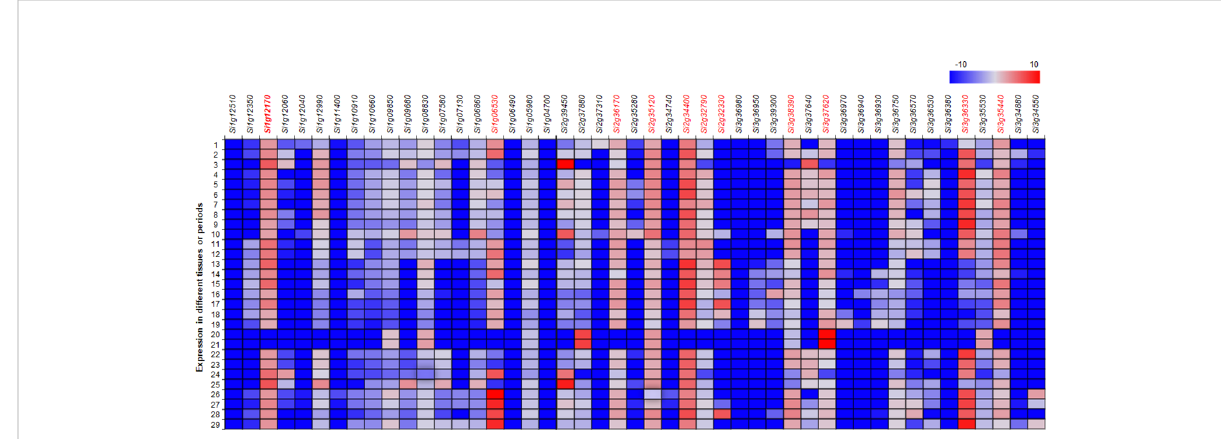
FIGURE 4 Heatmap for the expression of the annotated genes related to anthocyanin biosynthesis in the candidate genomic regions in 29 datasets of expression in foxtail millet. The datasets were extracted from MDSi: Multi-omics Database for Setaria italica (http://foxtail-millet.biocloud.net/). Genes expressed in developing seeds and panicles are indicated by red fonts. 1, JG21_Germinated-seeds_3-days; 2, JG21_Plant_one-tip-two- leaf; 3, JG21_Leaf-top-2-3_2-days-after-heading; 4, JG21_Neck-panicle-internodes_Filling-stage; 5, JG21_Flag-leaf_ fi lling-stage; 6, JG21_Flag-leaf-sheath_ fi lling-stage; 7, JG21_Stem-top-second_Filling-stage; 8, JG21_Leaf-top-foruth_ fi lling-stage; 9, JG21_Leaf-sheath-top- foruth_ fi lling-stage; 10, JG21_Root_Filling-stage; 11, JG21_Panicle_Primary-panicle-branch-differentiation-stage; 12, JG21_Panicle_Third- panicle-branch-differentiation-stage; 13, JG21_Immature-spikelet_S2; 14, JG21_Immature-spikelet_S4; 15, JG21_Immature-seed_S1; 16, JG21_Immature-seed_S2; 17, JG21_Immature-seed_S3; 18, JG21_Immature-seed_S4; 19, JG21_Immature-seed_S5; 20, JG21_Seed_30-days- after-maturation; 21, JG21_Seed_60-days-after-maturation; 22, JG21_Leaf-veins_S3; 23, JG21_Mesophyll_S3; 24, Xiaomi_Leaf_3-weeks-plant; 25, Xiaomi_Leaf-top-second_Boot-stage; 26, Xiaomi_Panicle_2-days-after-heading; 27, Xiaomi_Panicle_Pollination-stage;